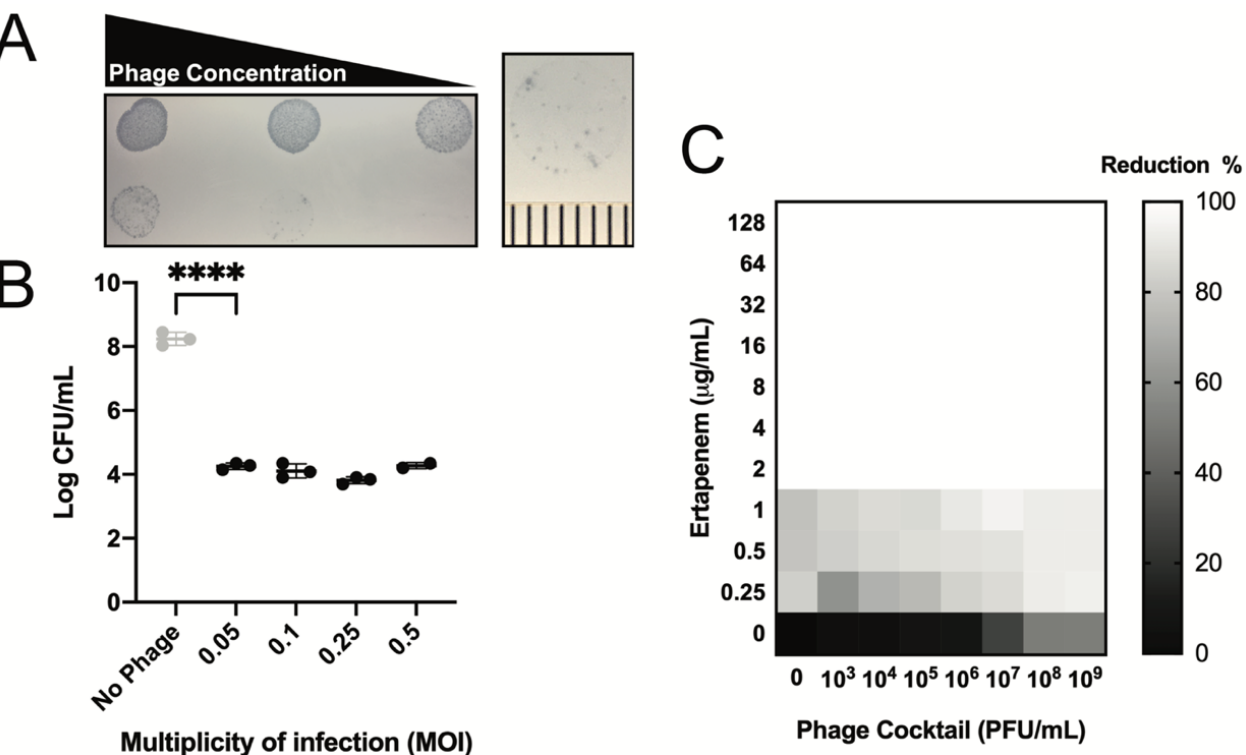
Figure 1. Characterization of UCS1 Cocktail. ( A ) Serial dilution of UCS1 Cocktail onto lawn of UCS1 E. coli . Each tick mark represents 1 mm. ( B ) Killing Assay. 10 6 CFUs of UCS1 E. coli were incubated without phage or indicated MOI of UCS1 cocktail for 4 h in 100 µL LB, and resulting CFUs counted. Error bars represent mean +/ − SD n = 3 technical replicates **** p < 0.001. ( C ) Synogram performed as described in Gu Liu et al. 2020 [39]. Each well of a 96-well plate was inoculated with 5 × 10 8 CFU of UCS1 and subjected to increasing concentrations of drug, phage cocktail, or both in LB and incubated/shaken at 37 ◦ C for 24 h. Optical Density 600 nM measurements were taken every 30 min. Values are reported as % reduction in growth at 24 h compared to untreated